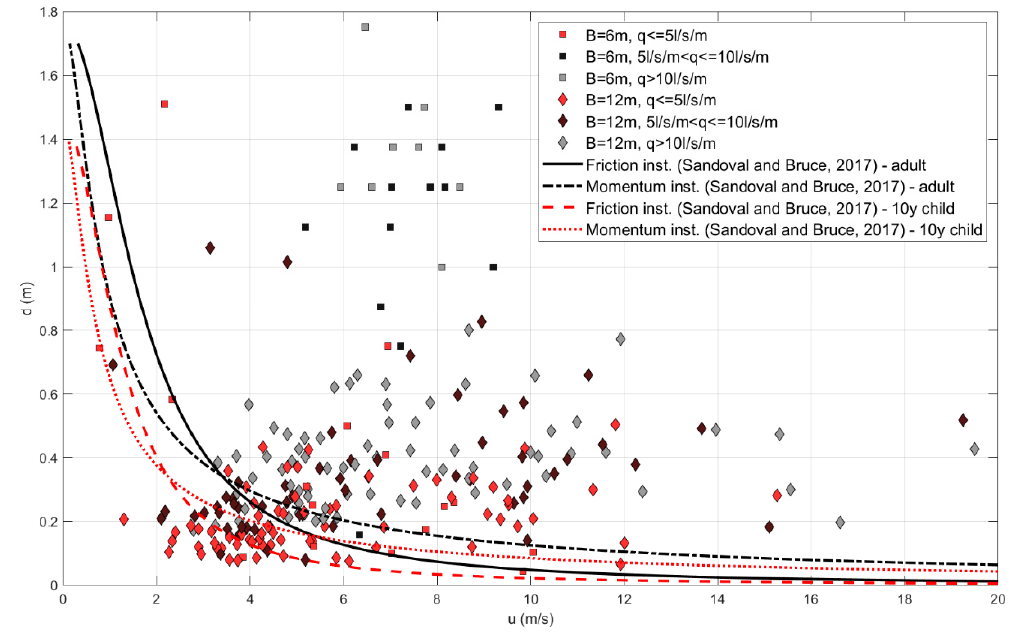
Figure19. Flowdepthversusvelocity, comparisonwithSandovalandBruce(2017)curves, thedischarges Figure 19. Flow depth versus velocity, comparison with Sandoval and Bruce (2017) curves, the are divided for di ff erent promenades and measured average discharges are divided for different promenades and measured average discharge.